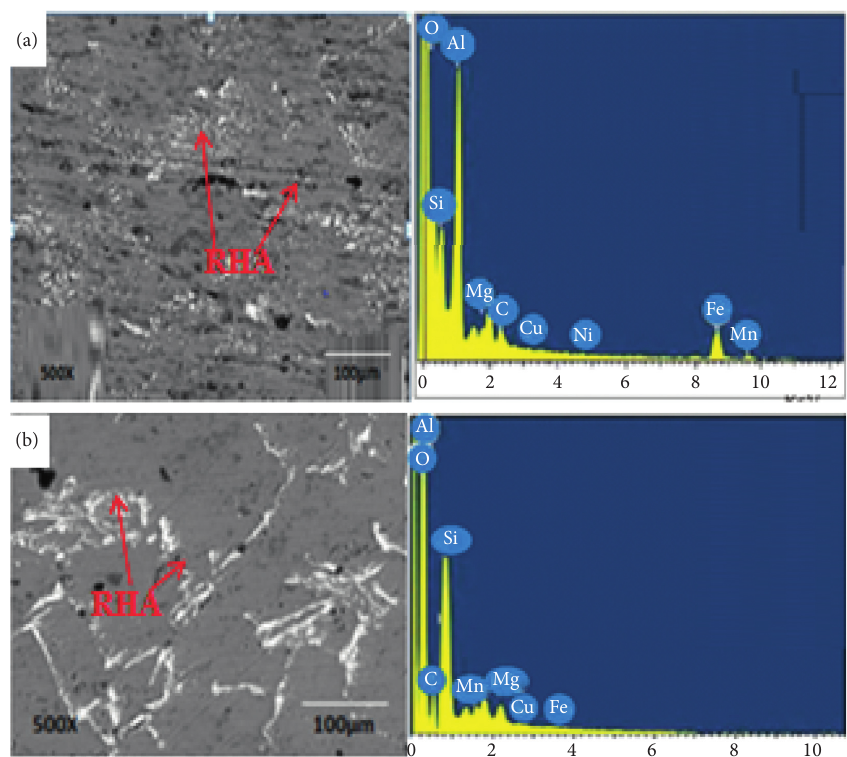
Figure 5: SEM micrograph showing (a) AA6061/2% RHA at 75 μ m and (b) AA6061/4% RHA at 75 μ